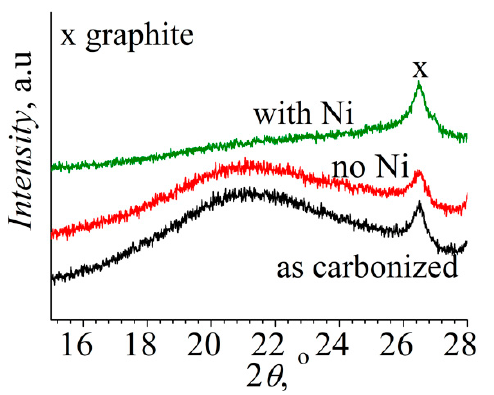
Figure 4. Reflexes in the 2 θ range of 15–28° angles for as carbonized sample, control and Ni-containing samples annealed at 900 ° С .